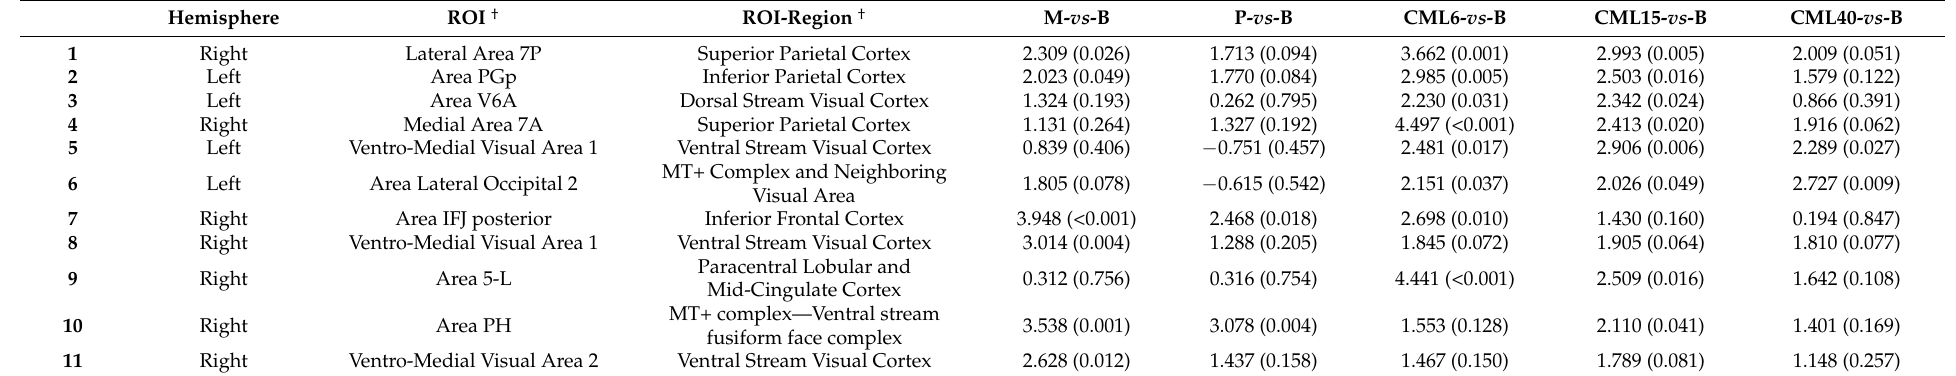
Table 3. Group differences ( t -tests) within each contrast map in the highest performance